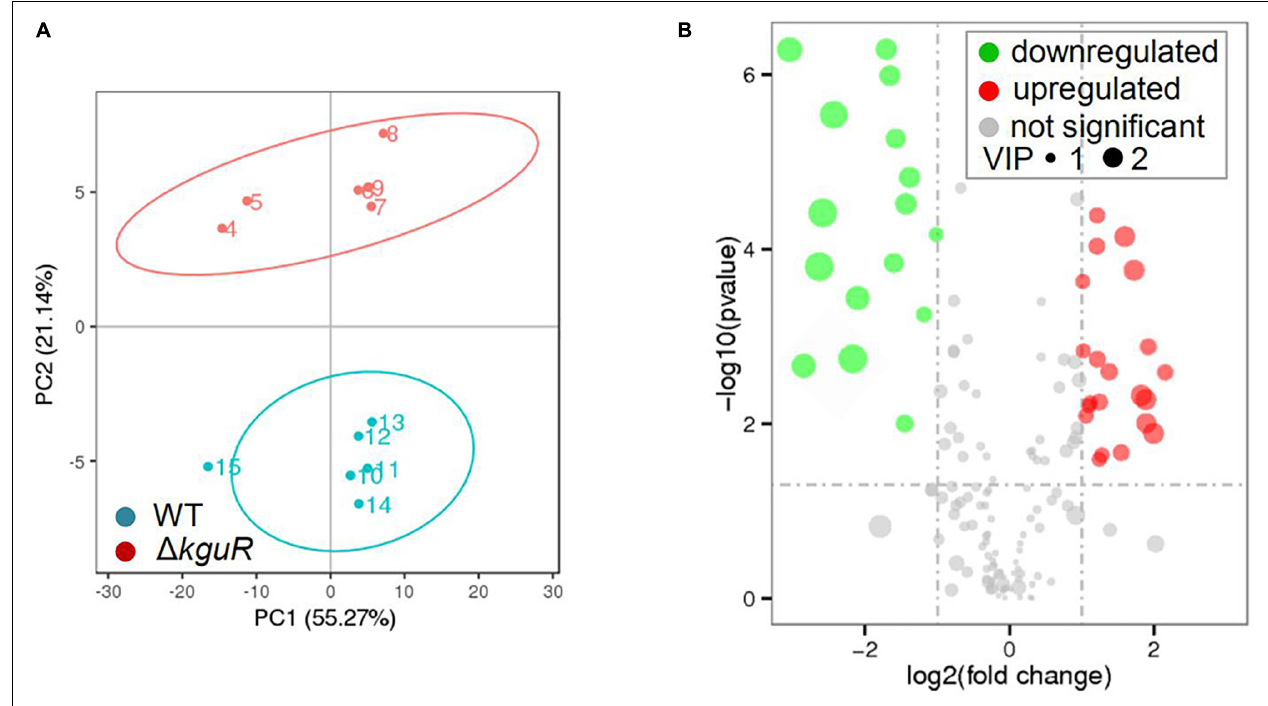
FIGURE 2 | Metabolic profiling of the (cid:49) kguR mutant and the WT. (A) Principal Component Analysis (PCA) of the WT and (cid:49) kguR groups, each containing 6 replicates. Numbers within the circles indicate the replicates in each group. (B) Volcano plot showing differentially produced metabolites in the (cid:49) kguR mutant compared to the WT. VIP, variable importance in the projection. A metabolite with VIP > 1.0, | log 2 (fold change) | > 1 and P- value < 0.05 was considered significant.